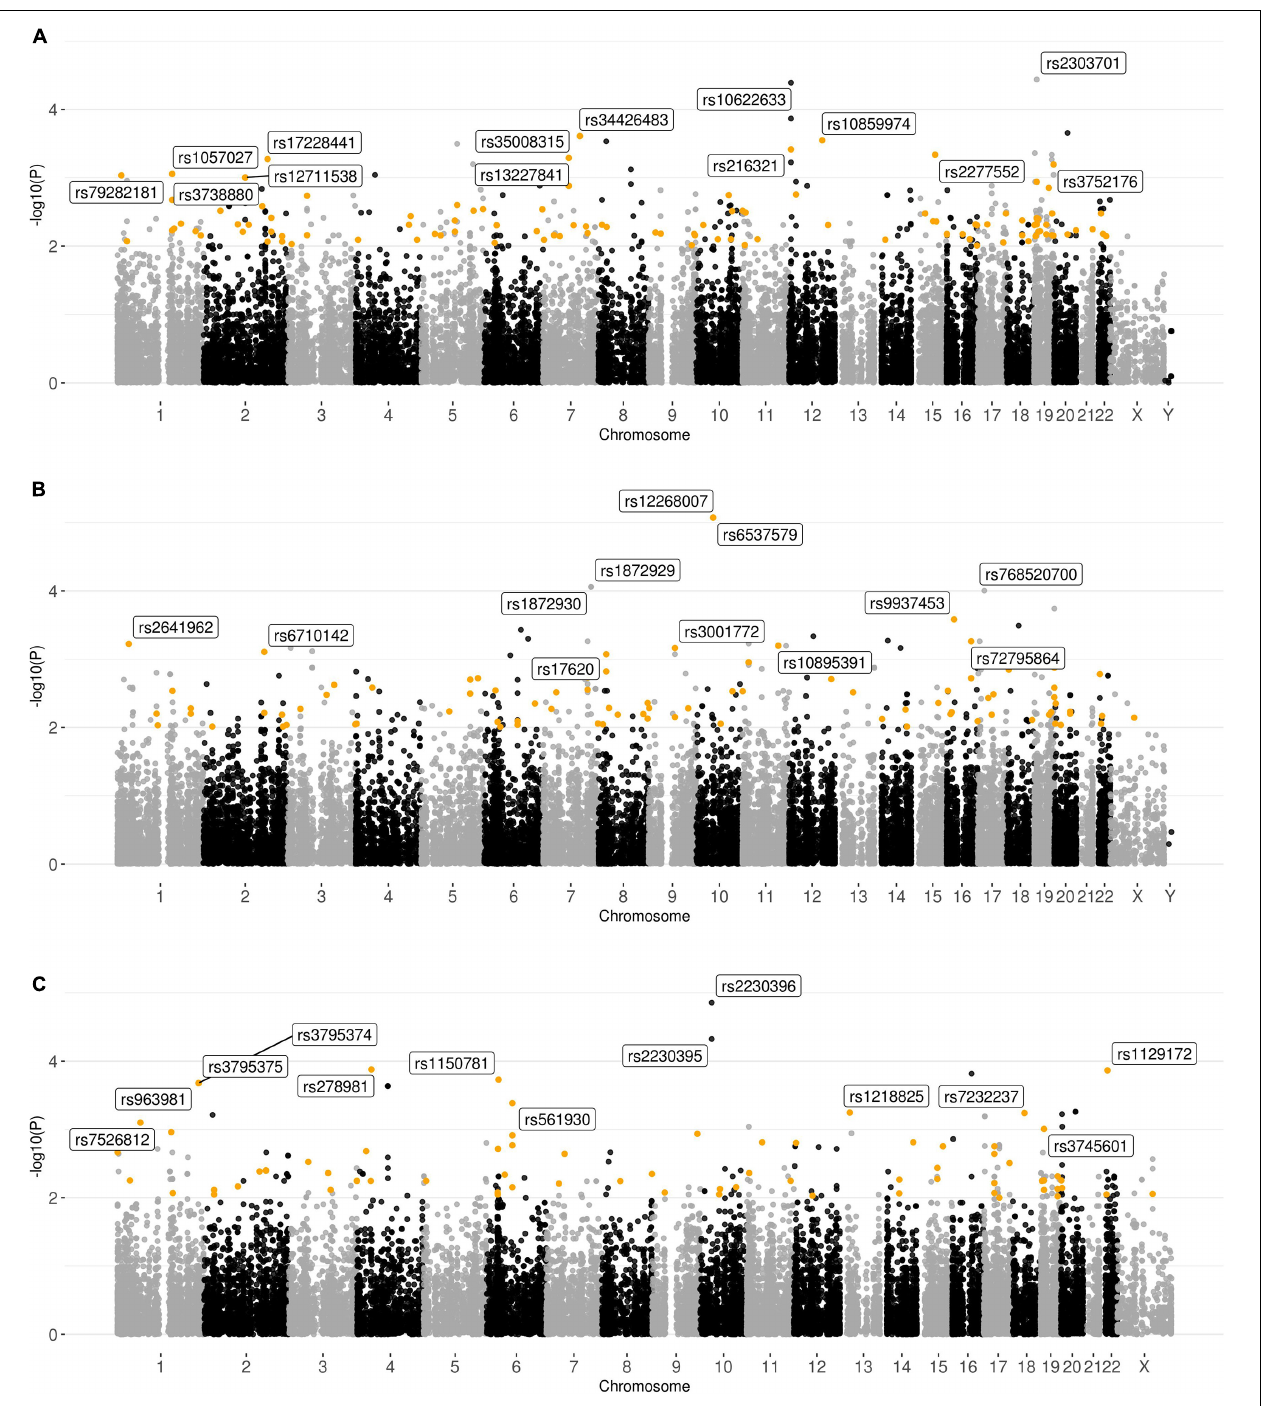
FIGURE 5 | Graphical summary of the results of the association analysis of the ethnic-specific sets of polymorphisms. Plot of –log10 ( p -values) of the χ 2 test. (A) Buryats; (B) Slavs; and (C) Yakuts. Polymorphisms with p -value < 10 − 2 and high or moderate impact based on the VEP results located in the genes expressed in the testis ( > 1NX) are